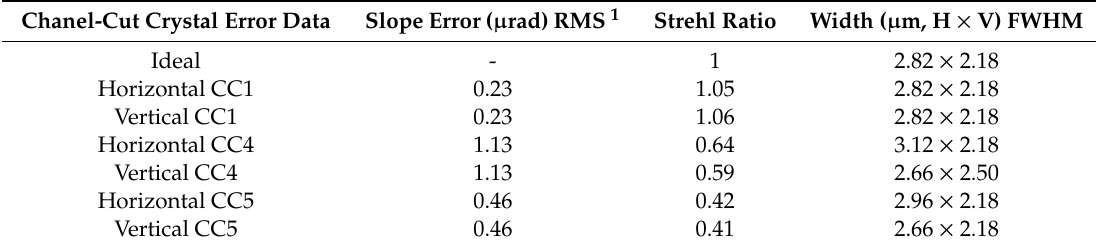
Table 6. The summarized performance of the simulated beamline with 5 µ rad acceptance angle. Chanel-Cut Crystal Error